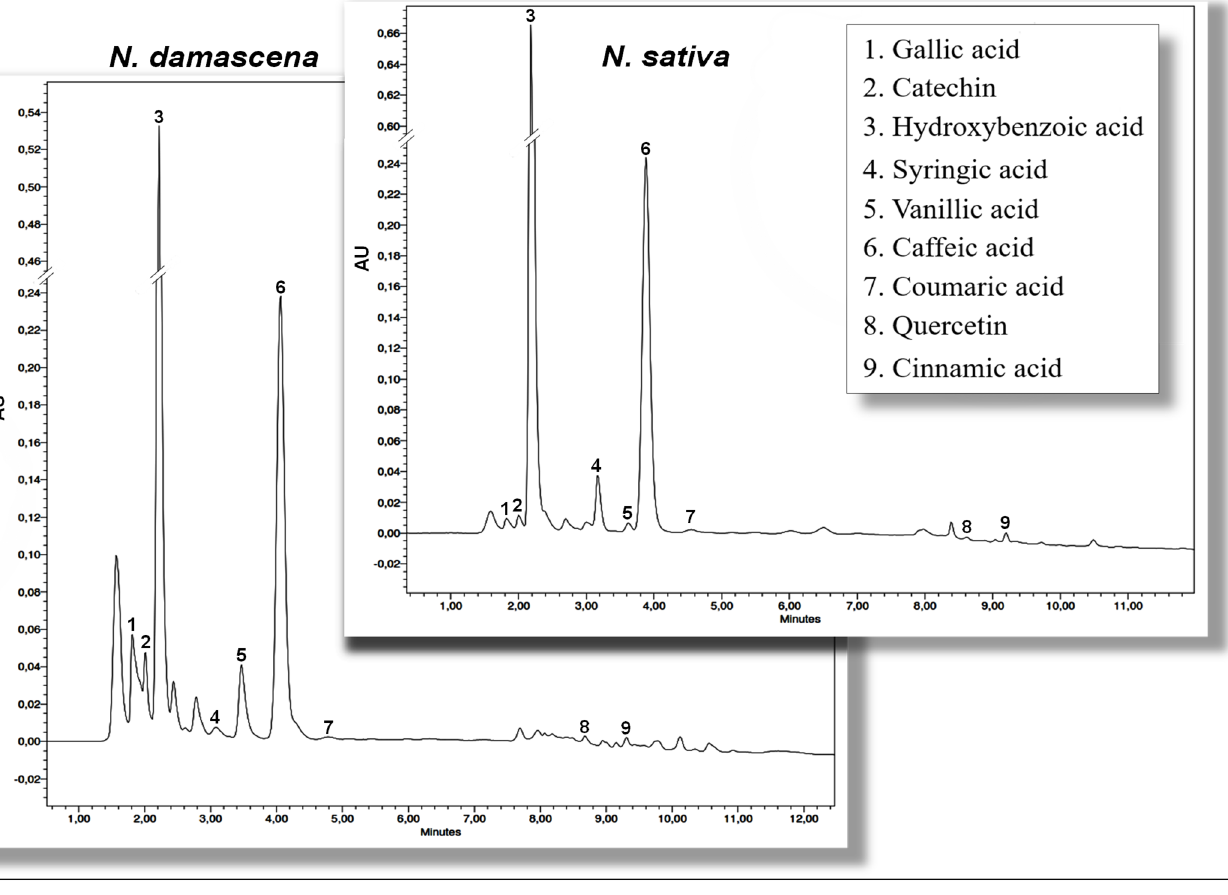
Figure 3. HPLC/DAD chromatographic profiles of Nigella damascena L. and Nigella sativa L. extracts monitored at 280 nm. Table 4. Phenolic acids and flavonoids identified and quantified from Nigella sativa L. and Nigella damascena L.